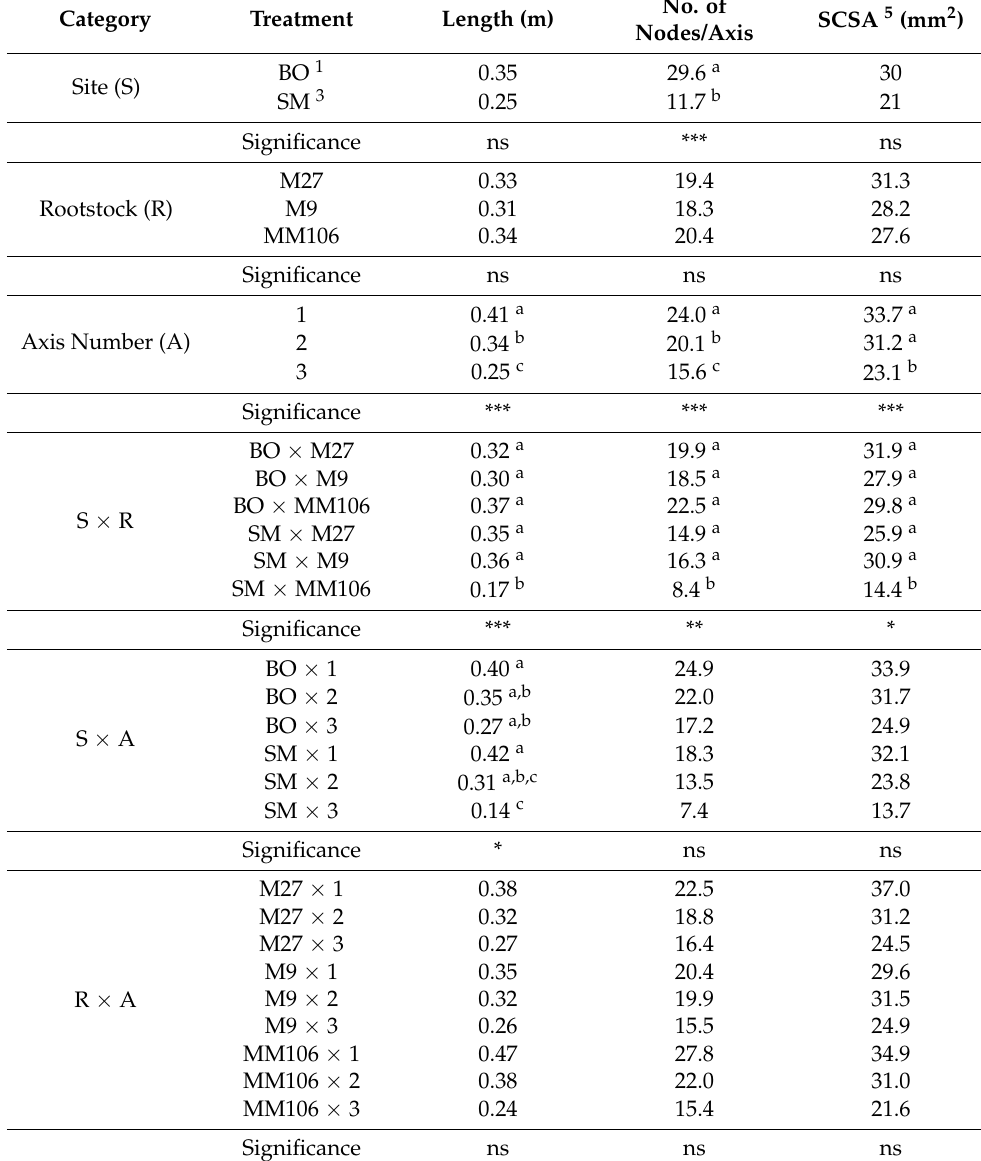
Table 5. Main effects of site of cultivation, rootstock, axis number, and their interactions on the growth attributes of second-order shoots in ‘Fuji’